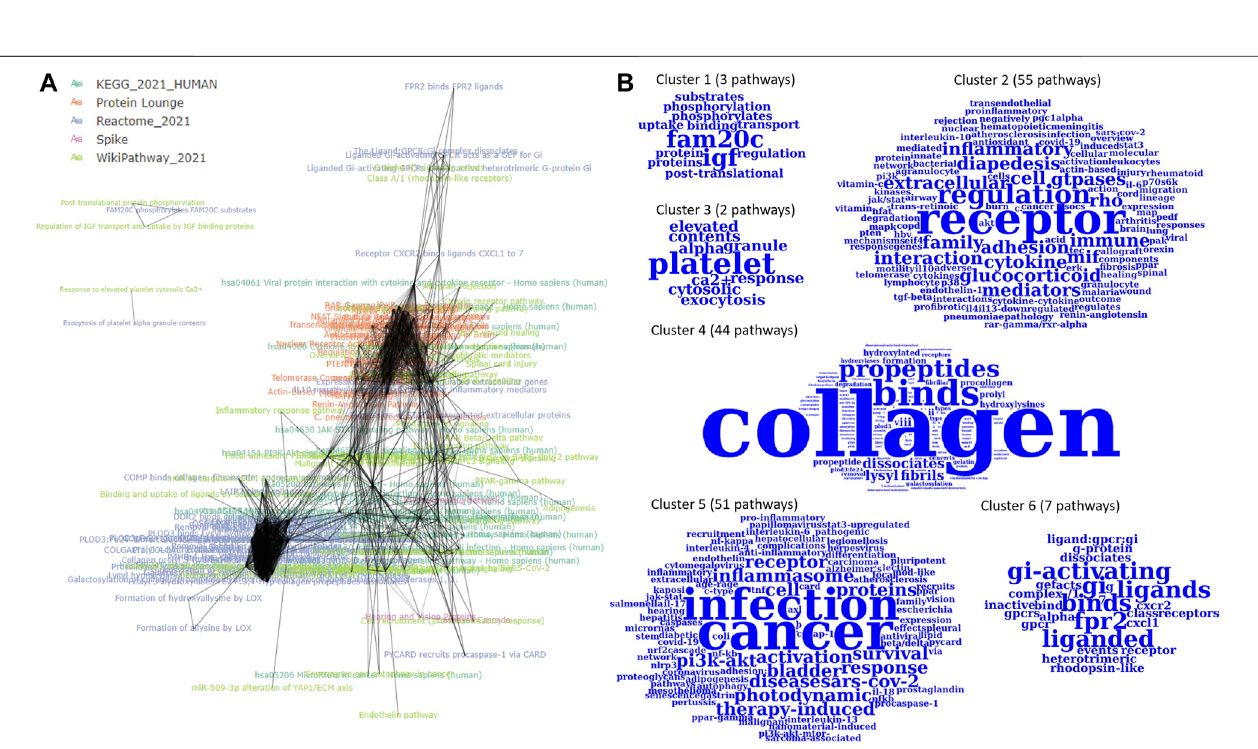
FIGURE 3 | The m-type PAG-to-PAG network of enriched P-type PAGs in PAGER for melanoma drug resistant-sensitive patients. (A) The m-type PAG-to-PAG network overview and (B) The extracted word clouds from the Louvain clusters in the network.